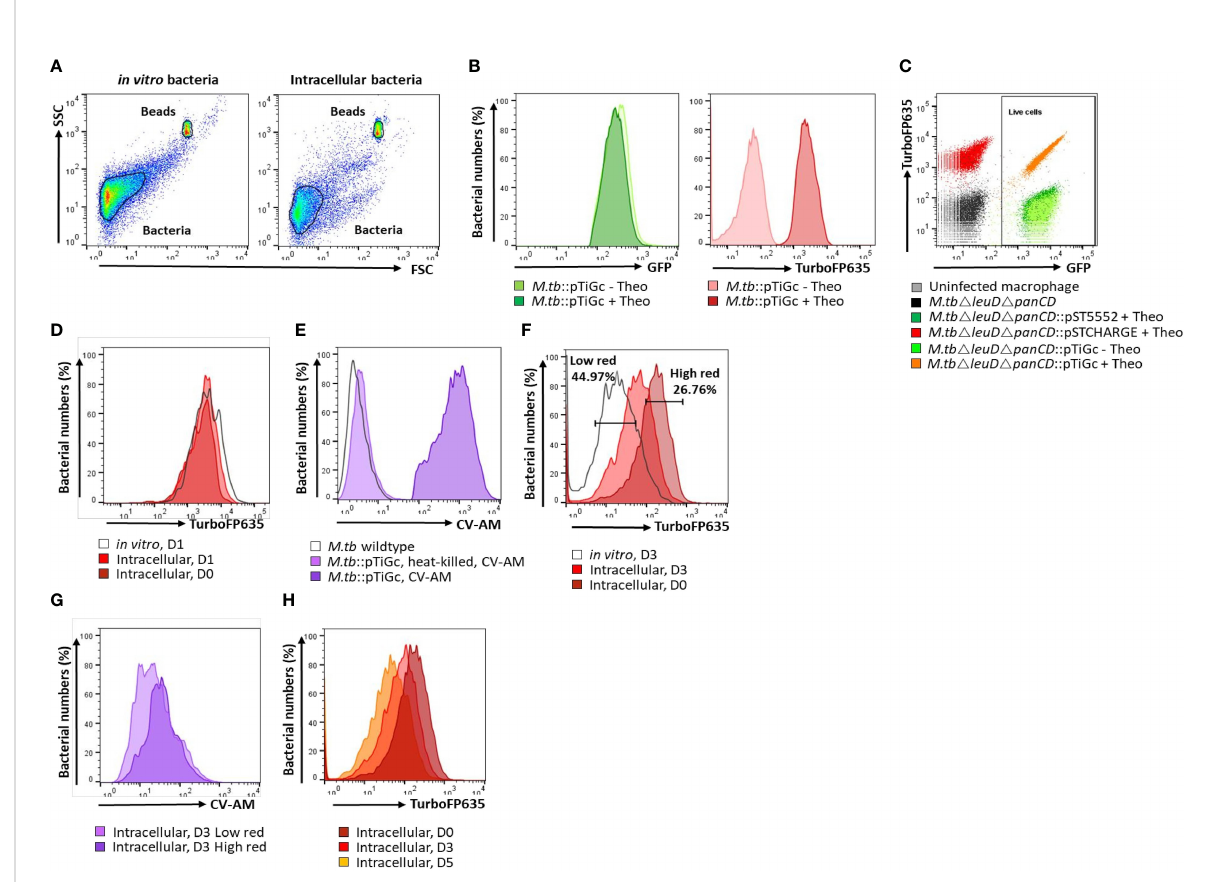
FIGURE 1 Flow cytometry gating strategy. (A) A primary gate was applied to the bacterial population according to forward scatter (FSC) and side scatter (SSC) properties. For cell enumeration, a secondary gate was applied to the non- fl uorescent bead population. (B) M. tuberculosis D leuD D panCD :: pTiGc was cultured in the presence of 4 mM theophylline to allow induction of the riboswitch-based promoter for expression of TurboFP635. Constitutive expression of GFP is observed, whilst fl uorescence of TurboFP635 is observed following induction with theophylline. (C) Selecting on the bacterial population, a rectangle gate was created to select for live cells, according to their GFP positivity. Single colour controls ensured optimal voltage settings for positive fl uorescence of GFP (pST5552) and TurboFP635 (pSTCHARGE), above that of the auto fl uorescence of unstained cells. (D) The fl uorescence dilution technique allows monitoring of bacterial replication for 5 generations. To improve detection of the fl uorescent signal to allow measurement over 5 days, theophylline, was retained in culture for 24 hours. Bacterial replication could thus effectively be monitored from day 2 onwards since the fl uorescent signal remained stable in vitro and intracellularly between day 0 and day 1. (E) Following harvesting of intracellular bacteria, cells were stained with CV-AM for analyses of metabolic esterase activity. CV-AM is a non-polar, cell permeable fl uorogenic probe that is rapidly hydrolysed to a polar, fl uorescent compound by intracellular esterases of live cells. Dead cells no longer possess esterase activity, and will thus not convert to the fl uorescent calcein, whilst calcein is stably retained in live cells. (F) Selecting on the live cells population, dilution of the TurboFP635 fl uorescent signal provided an indication of bacterial replication following removal of the inducer, theophylline (Theo). The high red gate was created based on maximum TurboFP635 fl uorescence observed at D0 using the range tool and used to detect mycobacteria that retain their TurboFP635 fl uorescence from later time points (D3 and D5), representing slow or non-growing bacteria. The low TurboFP635 gate was created to distinguish replicating intracellular bacteria, as visually assessed when overlayed with in vitro day 3 or day 5 bacteria. (G) Selecting on the high and low TurboFP635 subpopulations, the esterase activity of intracellular bacteria was assessed by overlaying on a histogram plot. (H) Fluorescence dilution of the TurboFP635 signal over time. The geometric median fl uorescent intensity (MFI) of TurboFP635 enabled determination of the number of bacterial generations during infection. CV-AM, calcein violet